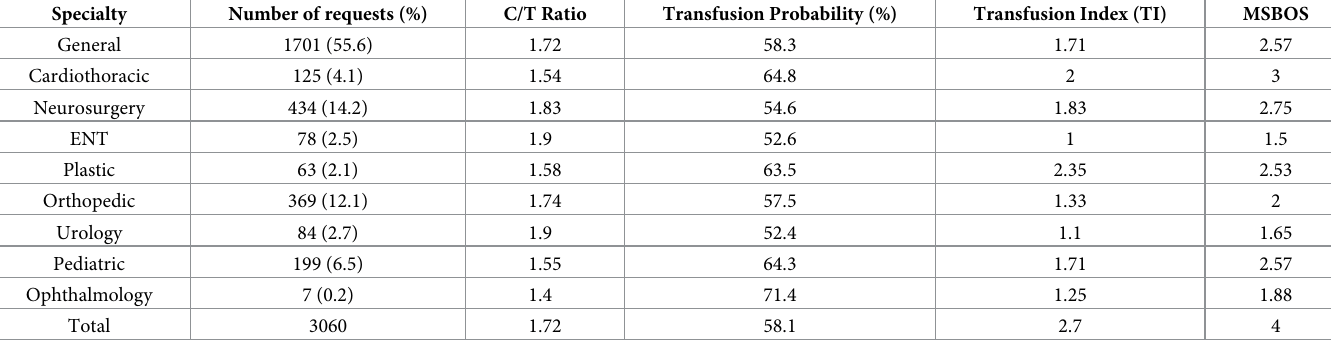
Table 5. Quality indicators for blood utilization for transfusion in surgical subspecialties.